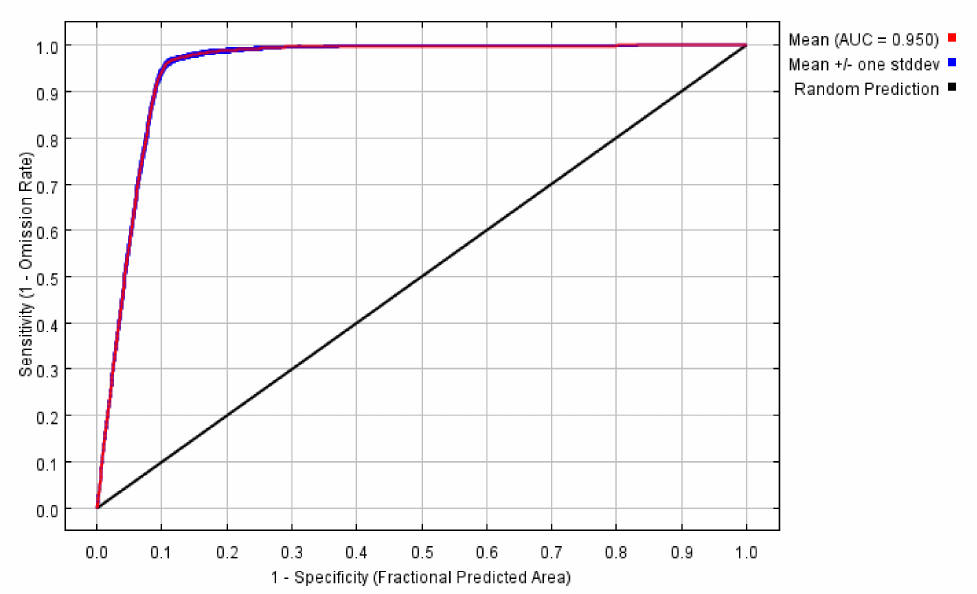
Figure 11. The AUC projected by the MaxEnt model of I. scapularis